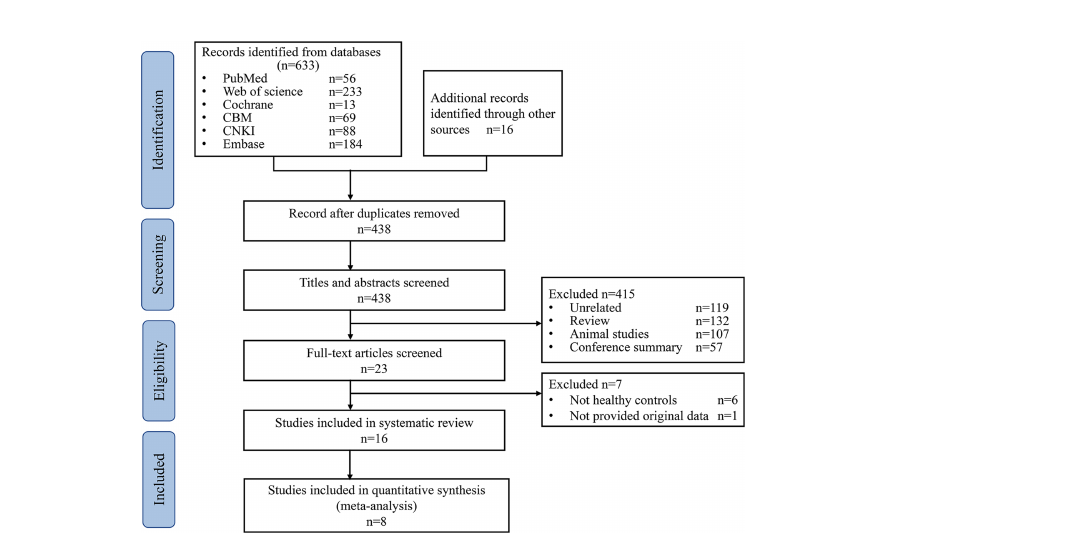
FIGURE 1 | PRISMA fl owcharts of study selection. CBM, Chinese Biomedical Databases. CNKI, China National Knowledge